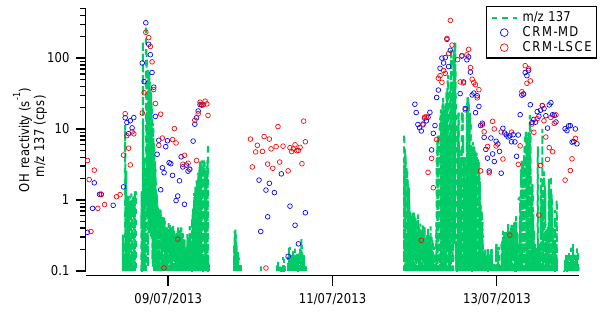
Figure 8. Time series of enclosure kOH (8–9 July), ambient kOH (10–11 July), enclosure kOH (12–13 July) measured by CRM- LSCE (red) and CRM-MD (blue). Total monoterpenes signal mea- sured by CRM-LSCE as protonated unfragmented m/z 137 is re- ported with the green